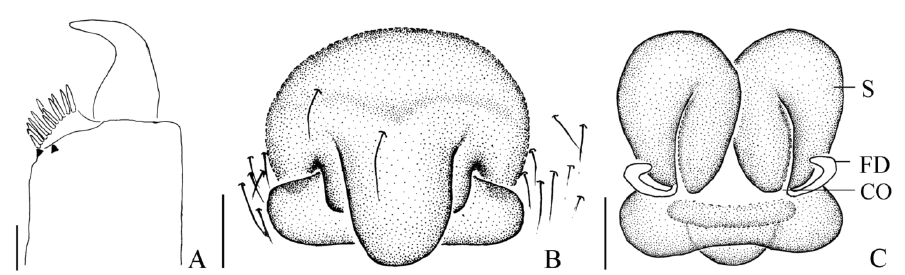
Figure 4. Mimetus echinatus Wang, 1990, from Shimen. A left chelicerae, ventral view B epigynum, ventral view C vulva, dorsal view. Scale bars: A–C ,